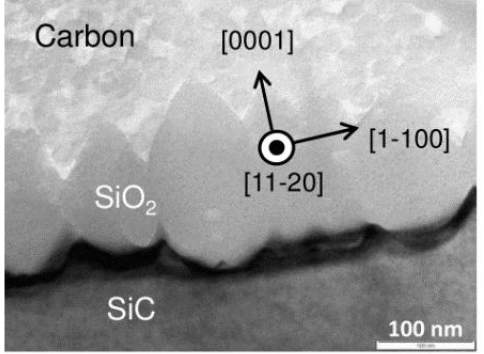
Figure 20. XTEM image of anodic oxidized 4H-SiC surface [48] .